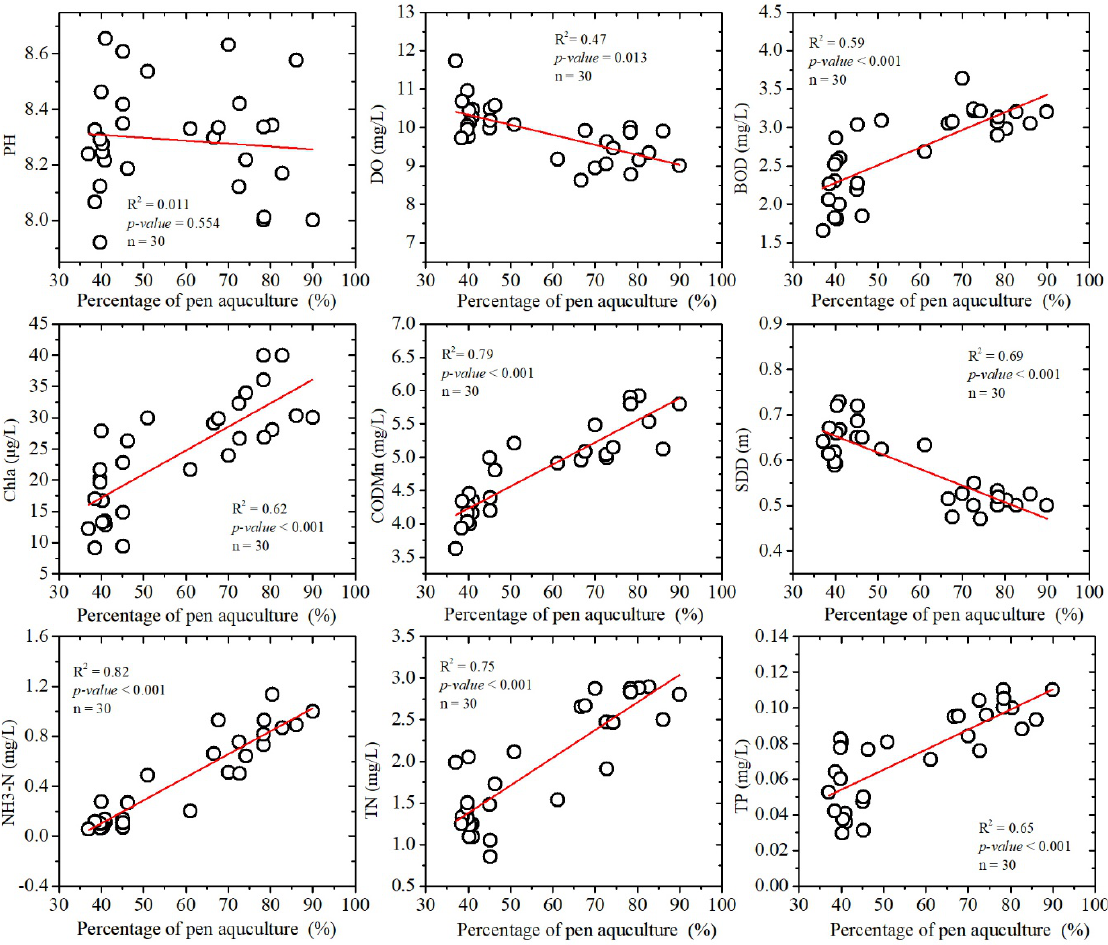
Figure 8. Correlations between the percentage of pen area and water quality parameters in the Central and Eastern Lakes. It excludes the Western Lake because there has been no pen in Western Lake since 2007.